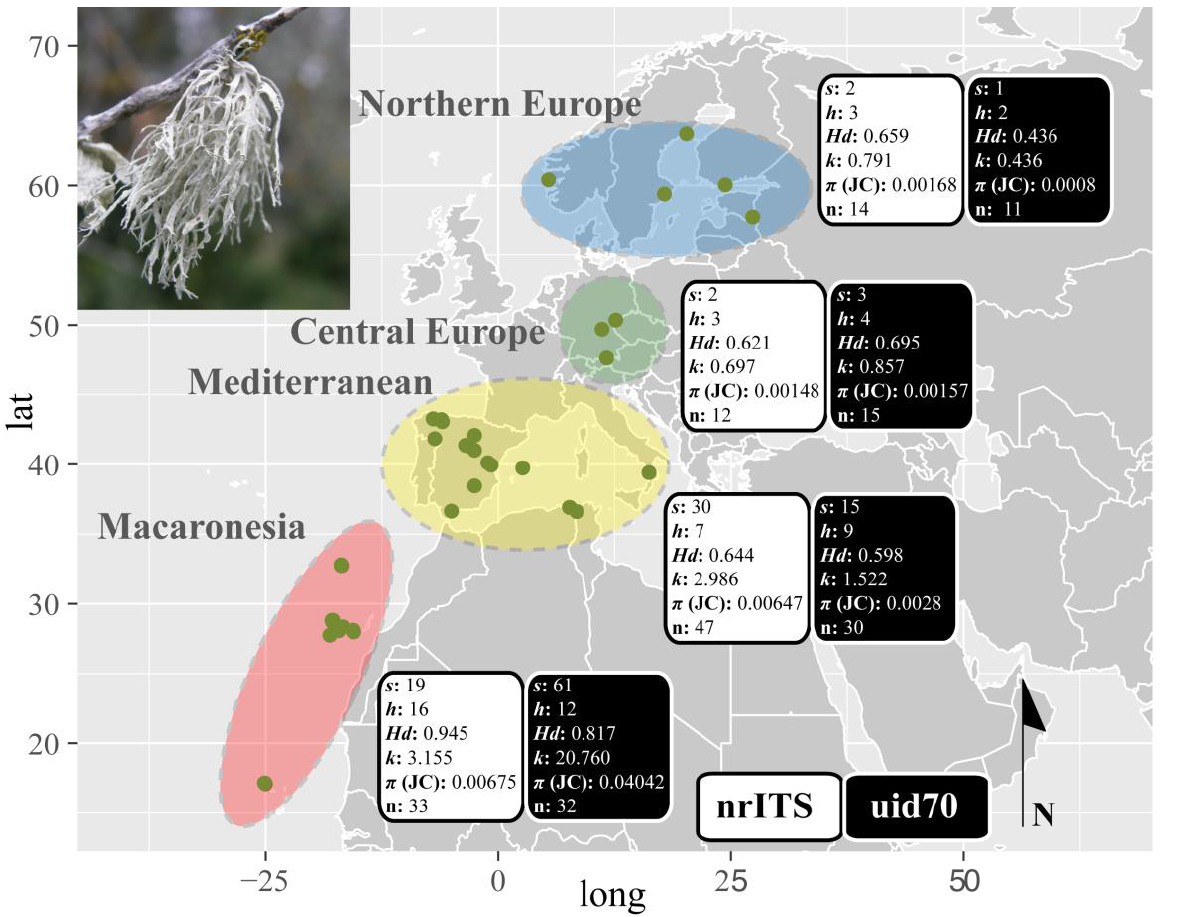
Figure 4. Georeferenced map showing the location of sampling localities (green dots) in the four studied geographic regions: Macaronesia (red circle), the Mediterranean Basin (yellow circle), and Central (green circle) and Northern Europe (blue circle). A summary of genetic polymorphism statistics considering nrITS (white rectangles) and uid70 (black rectangles) molecular sequence data is shown for each region. The inset shows the typical habitus of a Ramalina farinacea thallus growing on the dead branches of an olive tree in the Iberian Peninsula.